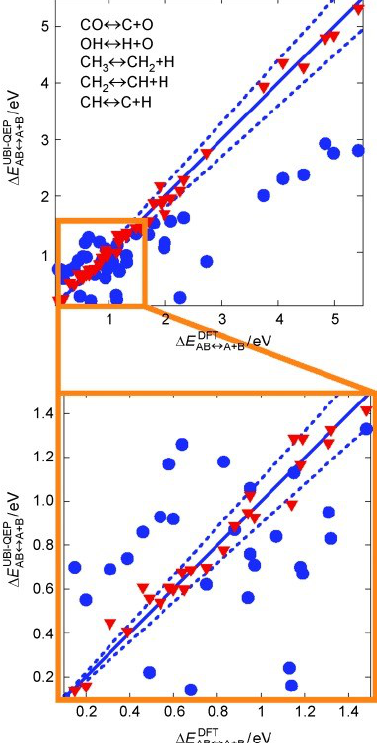
Figure 11. Parity plot of activation energies for several dissociation reactions on Rh(111) and Pt(111) as derived from the UBI-QEP and DFT (blue circle—original UBI-QEP; red triangle—refined UBI-QEP). Reprinted with permission from [94]. Copyright (2010) John Wiley and Sons.